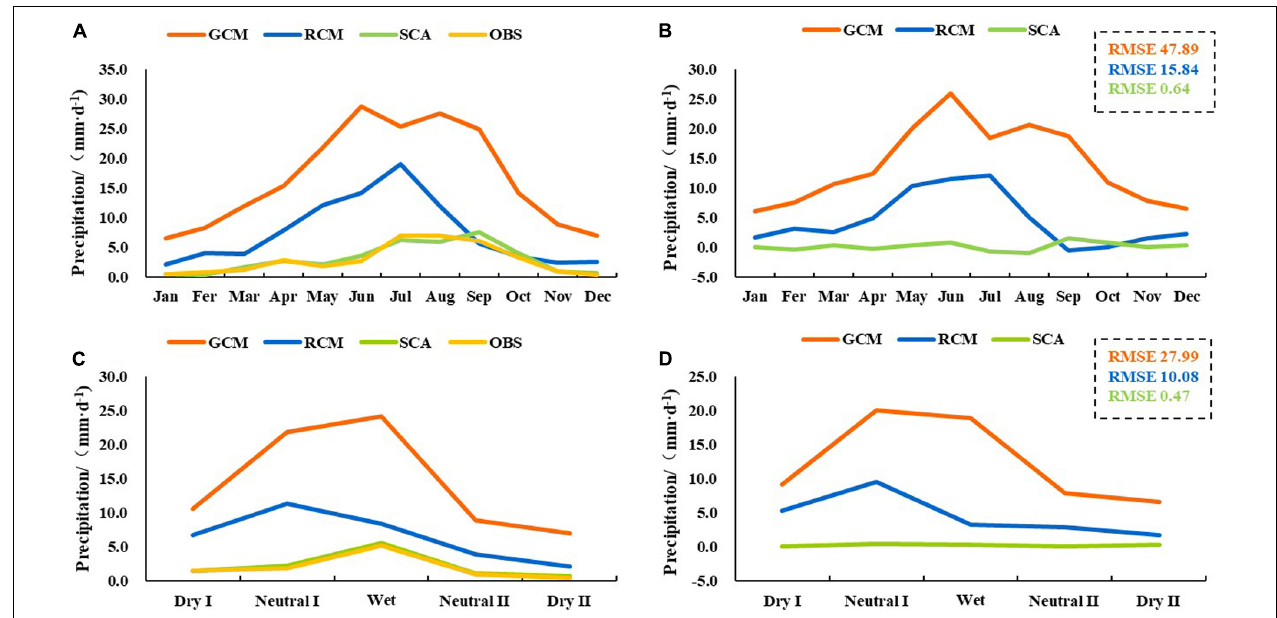
FIGURE 8 | Comparison of precipitation simulation and observed data in different scale models: (A) monthly precipitation; (B) monthly precipitation error; (C) precipitation in period; (D) precipitation error in period.